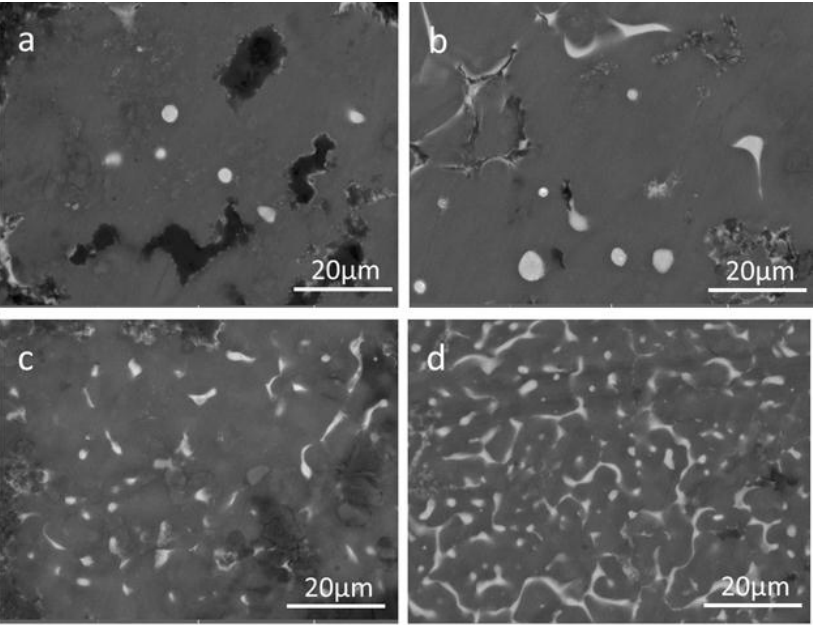
Figure 3. SEM micrograph of the Mg-Zn alloys: ( a ) Mg-2Zn; ( b ) Mg-4Zn; ( c ) Mg-6Zn and ( d ) Mg-8Zn.